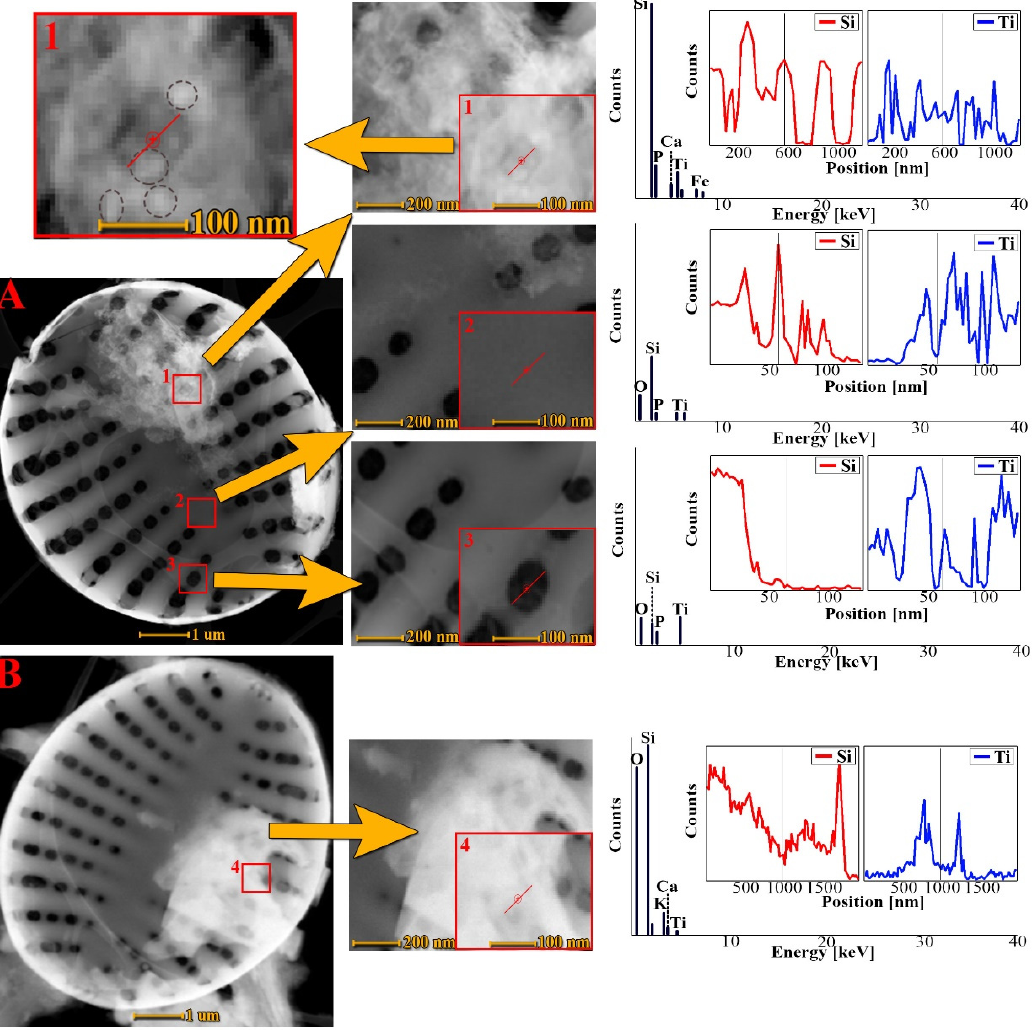
Figure 5. TEM images of diatomaceous biosilica ( A ) and biomass ( B ) doped with titanium ions ( A ), STEM-EDX spectra and scans of elementary lines of Ti and Si in four representative places of diatom cells: on the surface of a flake of purified biosilica (A.1.), on ribs (A.2.) in the pore cross-section (A.3) and on the surface of the flake incorporated on the cell of the unpurified biomass (B.4). In the zoom of figure A.1, the dashed black line shows titanium quasi-ooid forms.